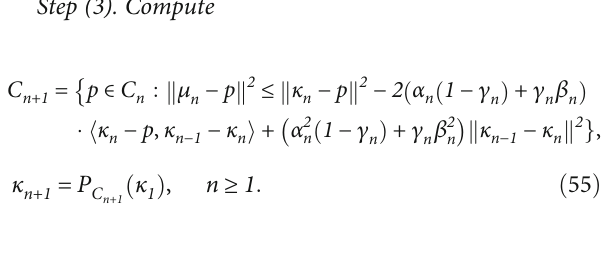
= κ = 3 e t sin ð t Þ . 0 1